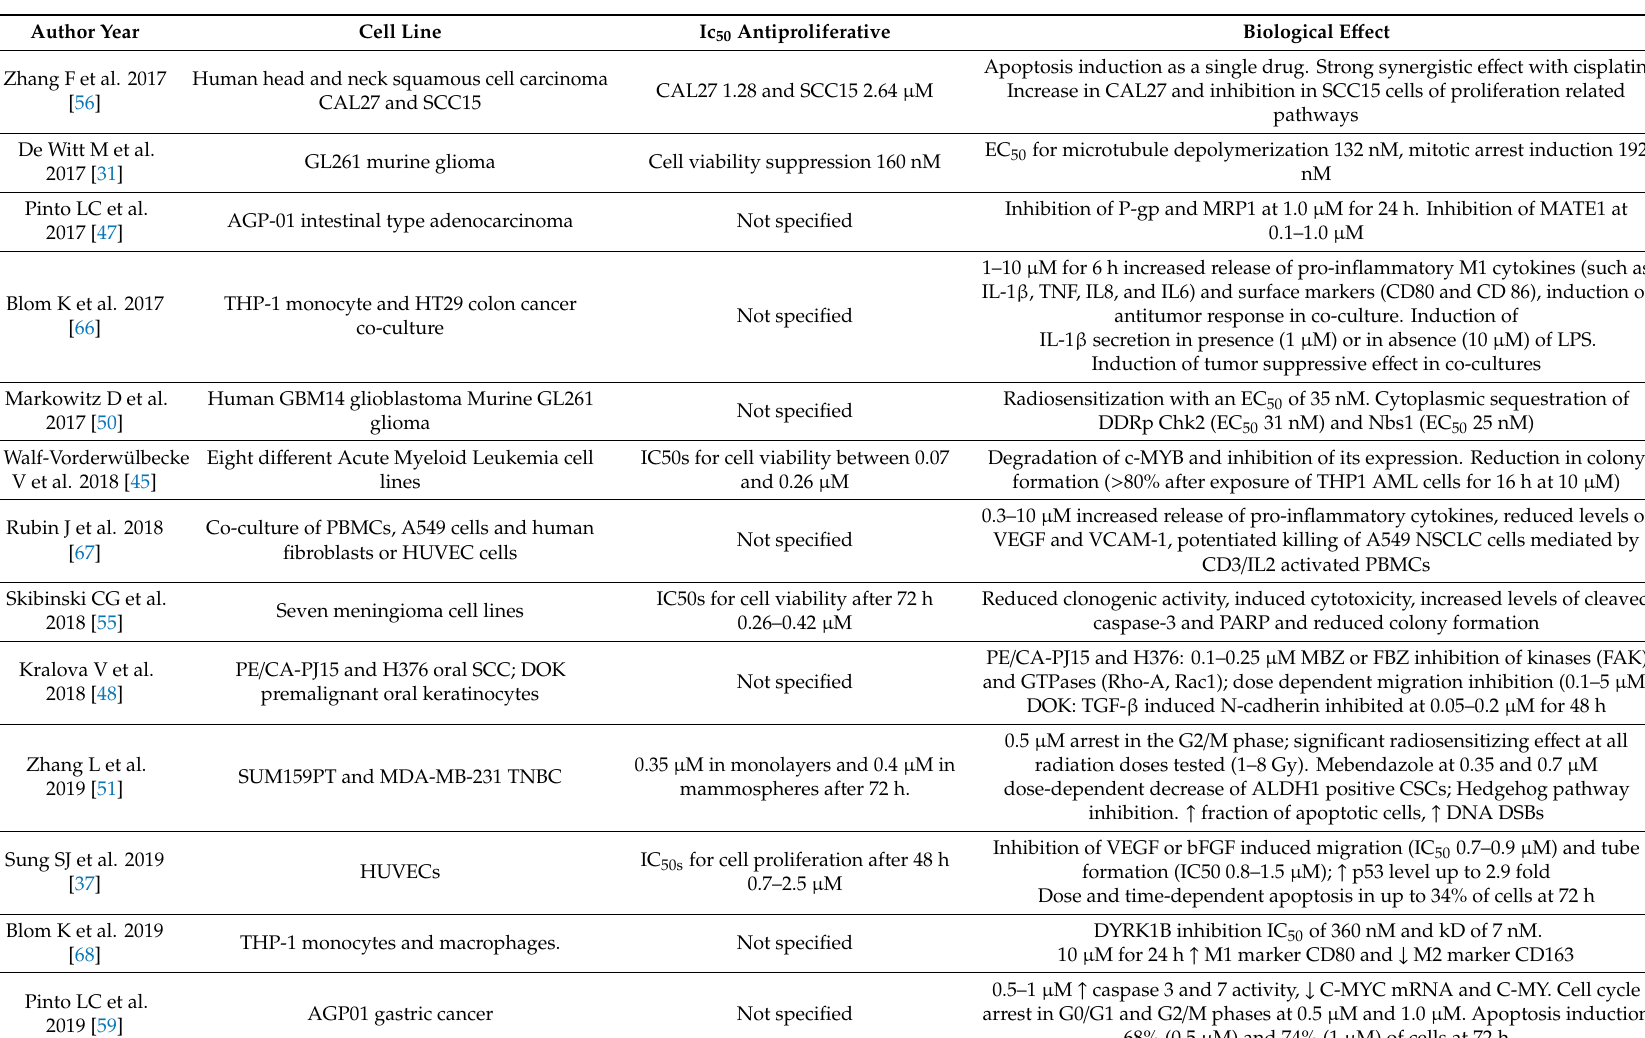
Table 3. Studies reporting MBZ anticancer activity in vitro and its mechanisms of action. IC 50 = half maximal inhibitory concentration; EC 50 = concentration required to achieve a half-maximal e ff